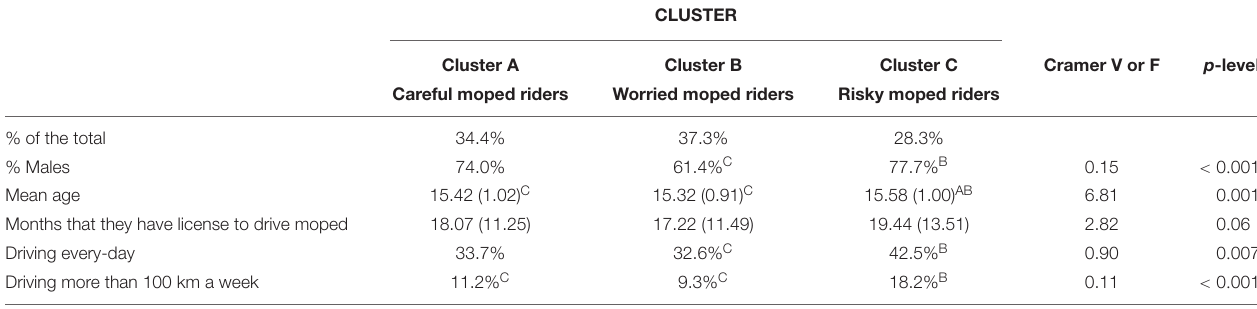
TABLE 3 | Cluster differences on descriptive measures.